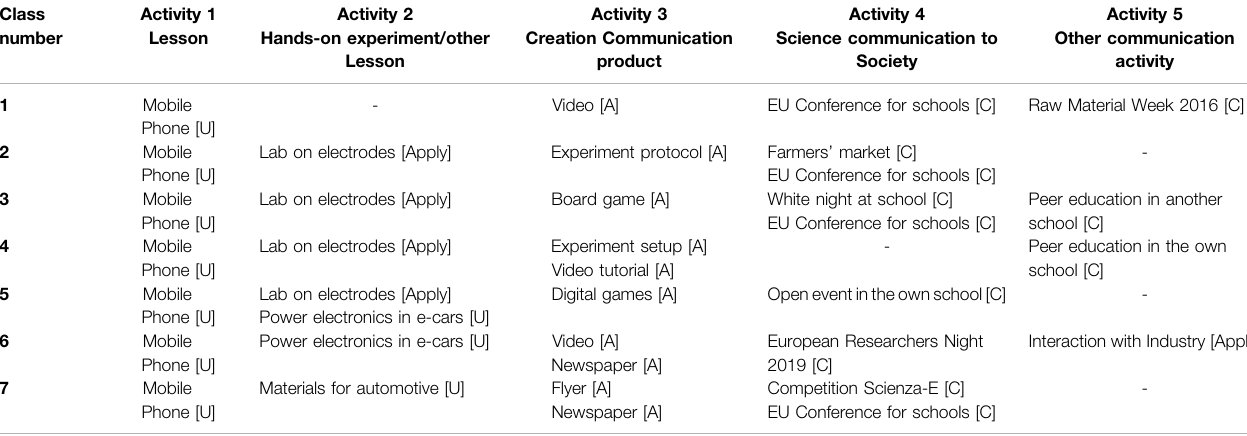
TABLE 2 | Summary of the activities carried out by the seven classes involved in this case-study; the cognitive skills reached in each activity included the learning path are indicated in square